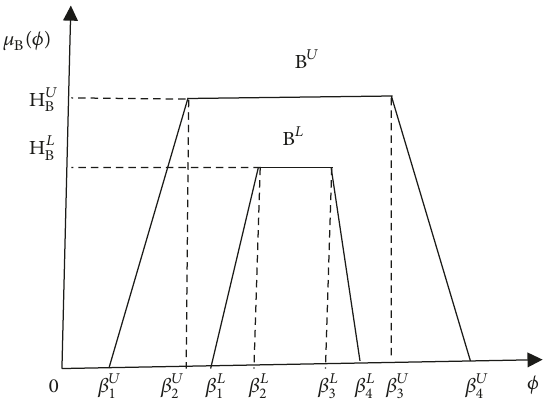
Figure 2: A geometrical interpretation of an